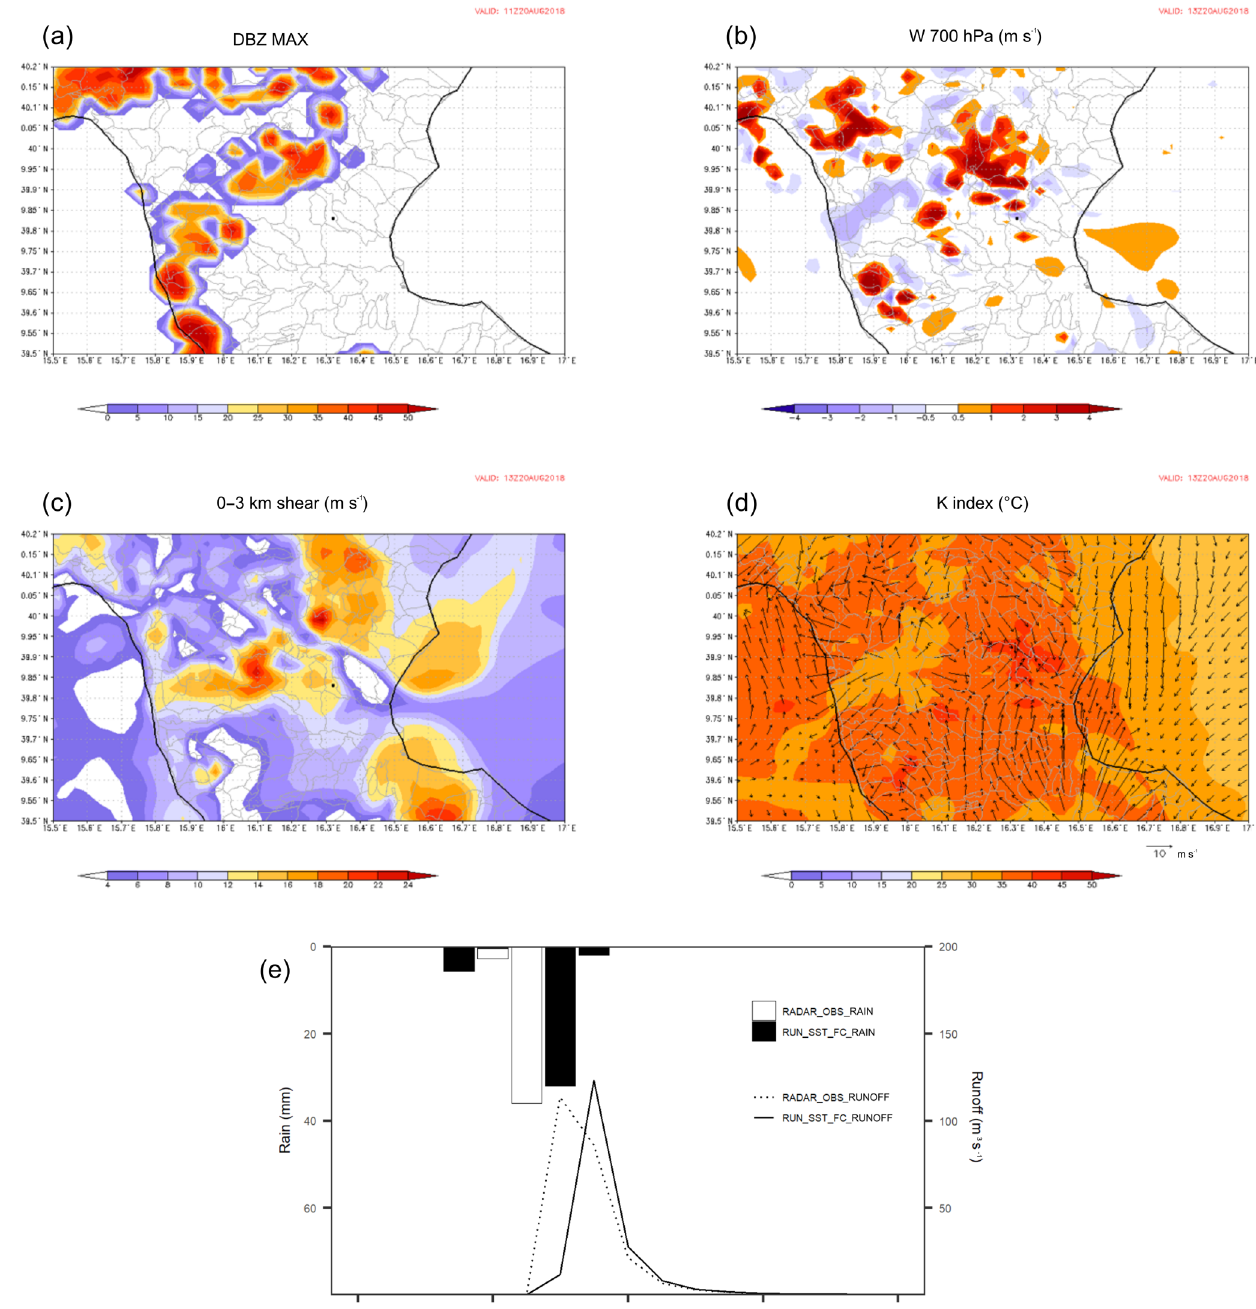
Figure 3. (a) Maximum reflectivity simulated at 11:00UTC (dBZ); (b) 700hPa vertical wind speed simulated at 13:00UTC (ms − 1 ); (c) 0– 3km wind shear simulated at 13:00UTC (ms − 1 ); (d) k index simulated at 13:00UTC ( ◦ C); (e) hourly averaged rainfall values over the catchment (mm) and the resulting hydrograph (m 3 s − 1 ) achieved for radar-driven simulations and RUN_SST_FC. Results shown in panels (a) to (d) are achieved with the run